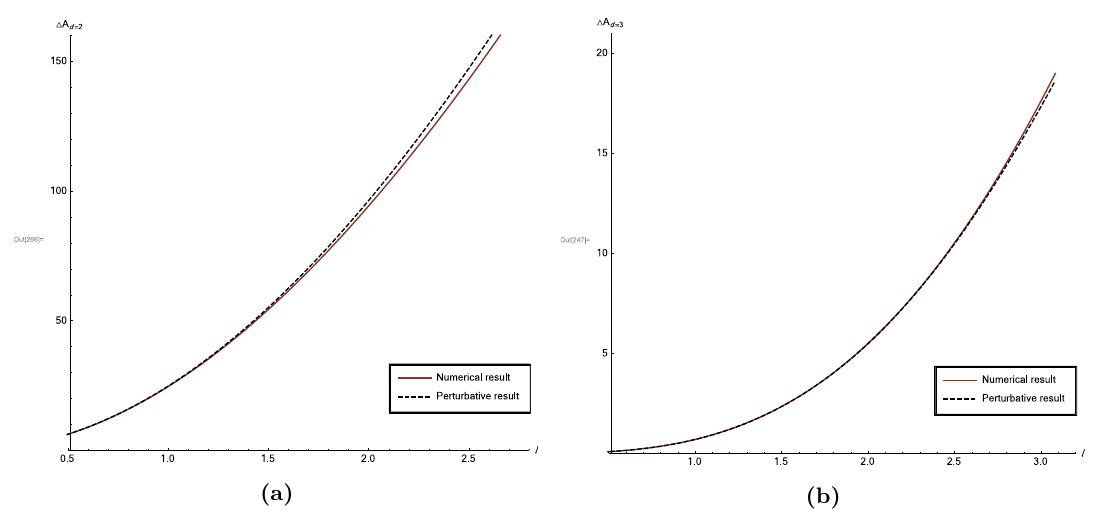
√ 10 , the dashed curves are obtained from